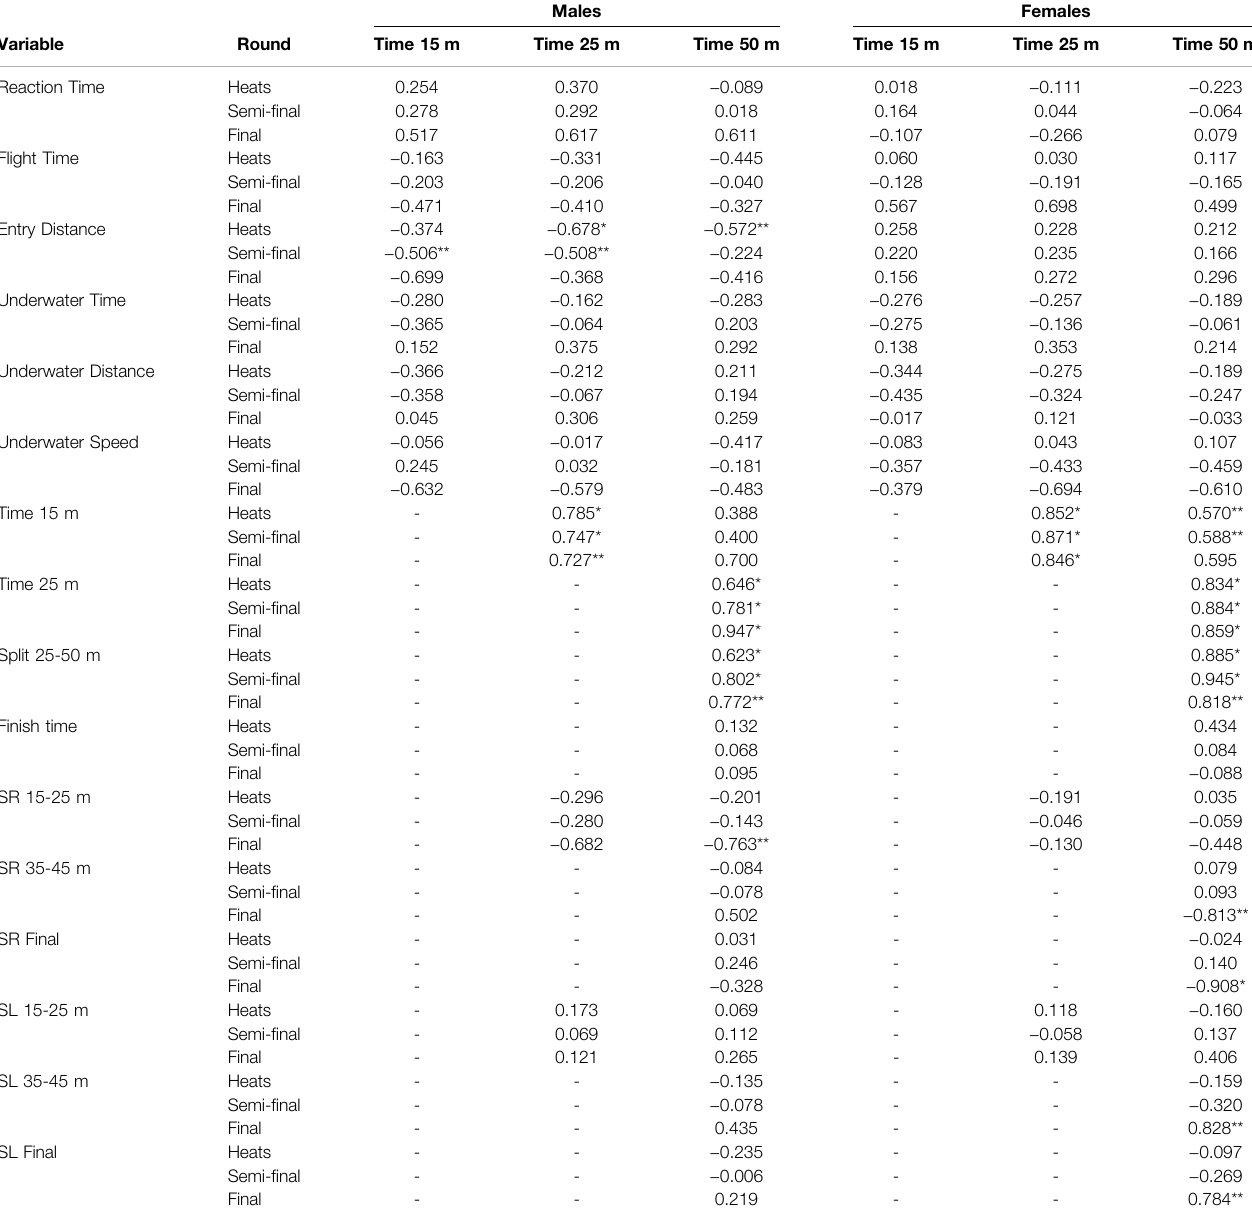
TABLE 9 | Pearson correlation coef fi cients (r) of the 50 m Freestyle ’ s competition variables (LEN European Senior Championships 2021). Males Females Variable Round Time 15 m Time 25 m Time 50 m Time 15 m Time 25 m Time 50 m Reaction Time